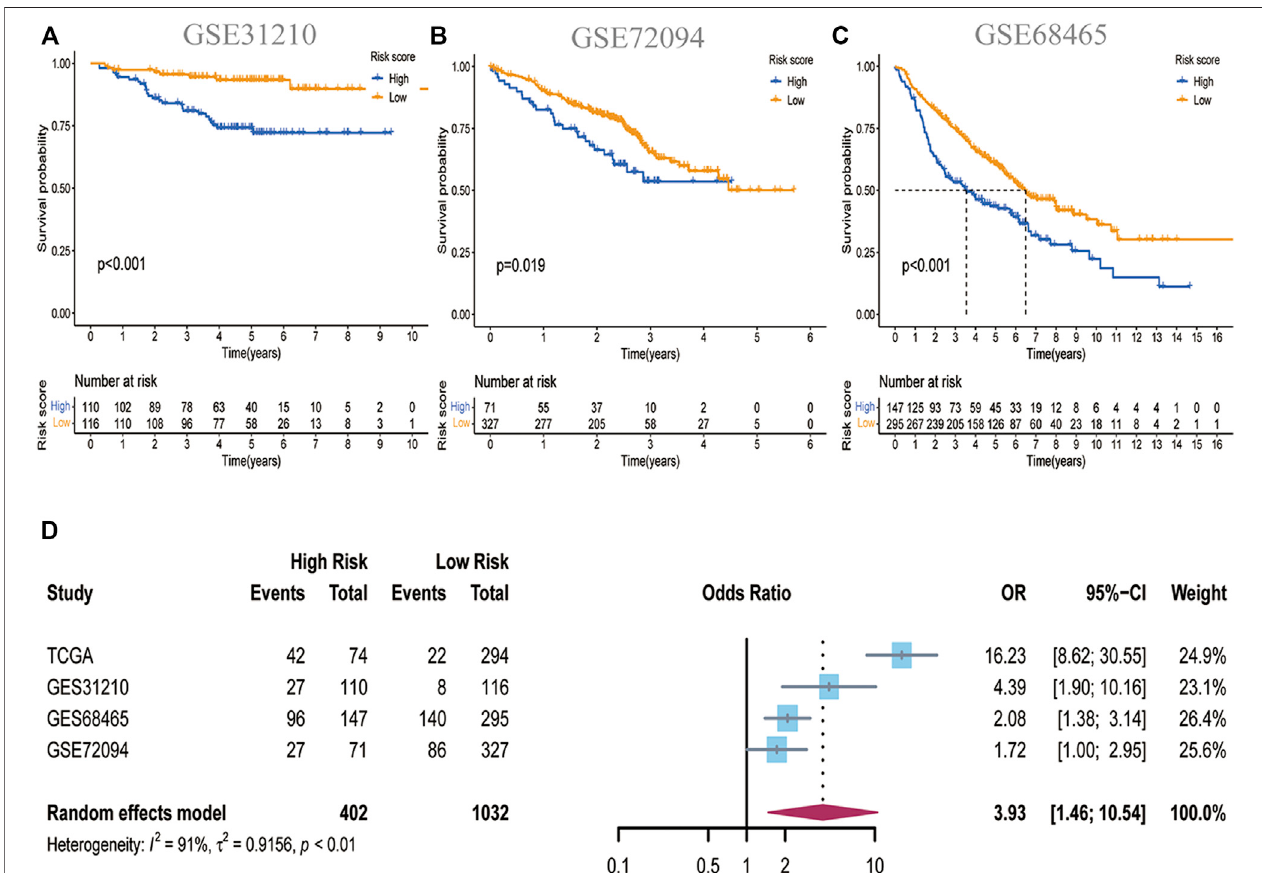
FIGURE 3 | Validation of the PCD-related signature in GEO datasets. (A) Kaplan-Meier curves showing the signi fi cance of OS in GSE31210 (n = 226) (B) in GSE 72094 (n = 398) and (C) in GSE68465 (n = 443). (D) A meta-analysis showed the prognostic outcomes in four independent datasets (HR:3.93; 95%CI:1.46 – 10.54).